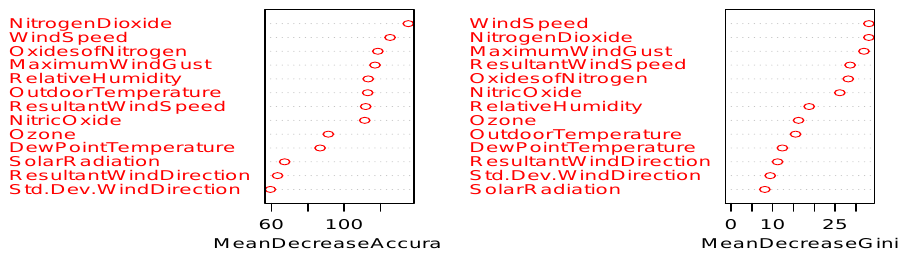
Figure 8. Variable importance plot using mean decrease accuracy and Gini indices.